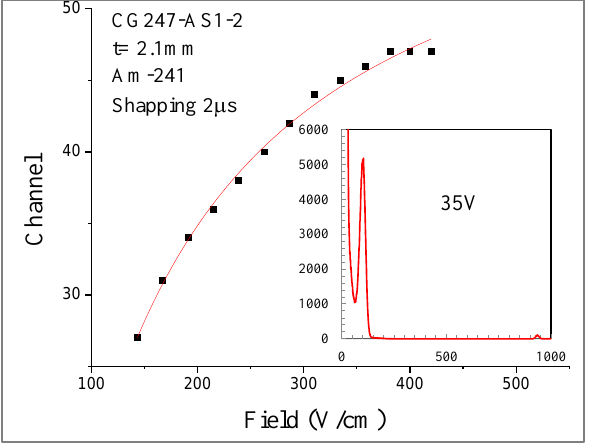
Figure 14. µτ e measurements (~1.3 × 10 −3 cm 2 /V) and gamma response to 241 Am for CRY-4.